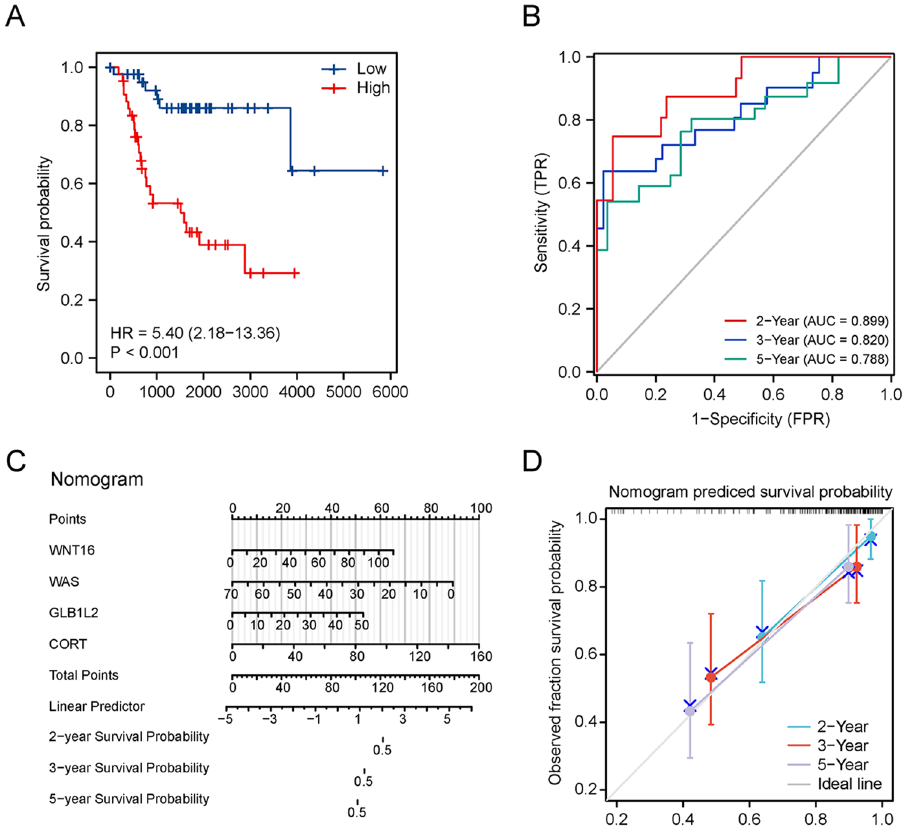
Figure 5. Construction of a prognostic model. ( A ) Kaplan–Meier survival curves indicated that the probability of premature death was higher in high-risk subgroup patients than in low-risk subgroup patients. ( B ) Time- dependent Receiver Operating Characteristic (ROC) curves were plotted to validate the prognostic model, with good discrimination in 2, 3, and 5 years. ( C ) Nomogram based on multivariate Cox regressions to predict the survival probability of OS patients. ( D ) Calibration curves of the nomogram, demonstrating a high prediction